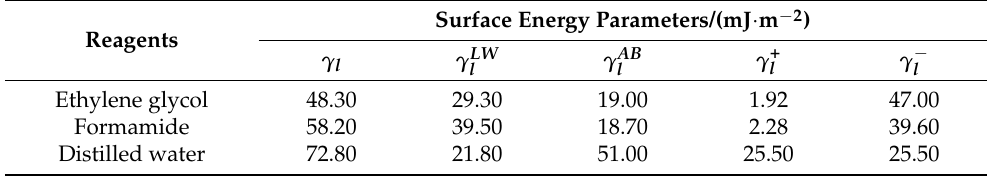
Table 4. Surface energy parameters of liquid reagents.